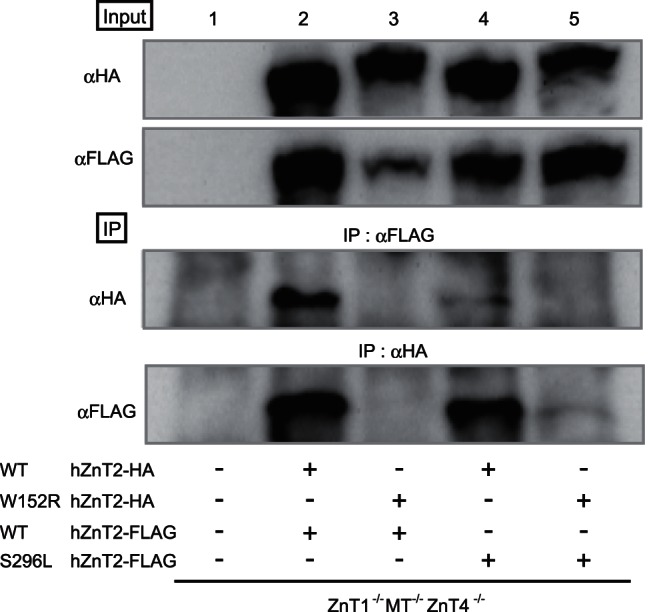
W152R hZnT2 mutant is not dominant negative because it fails to form functional dimers.Tagged-hZnT2 WT or mutants were immunoprecipitated (IP) with antibodies against either the FLAG or HA epitopes. The immunoprecipitates were analyzed by immunoblotting using antibodies against the FLAG or HA tags. To estimate the amount of tagged hZnT2 WT and mutant proteins, 10% of each aliquot was subjected to immunoblot analysis (input panels). The IP experiments were performed four times, which gave the same results. The panels show the representative results.